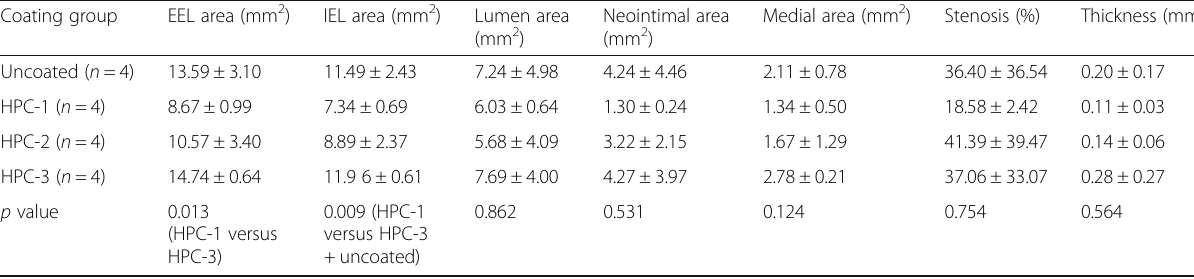
Table 5 Morphological measurements scoring Coating